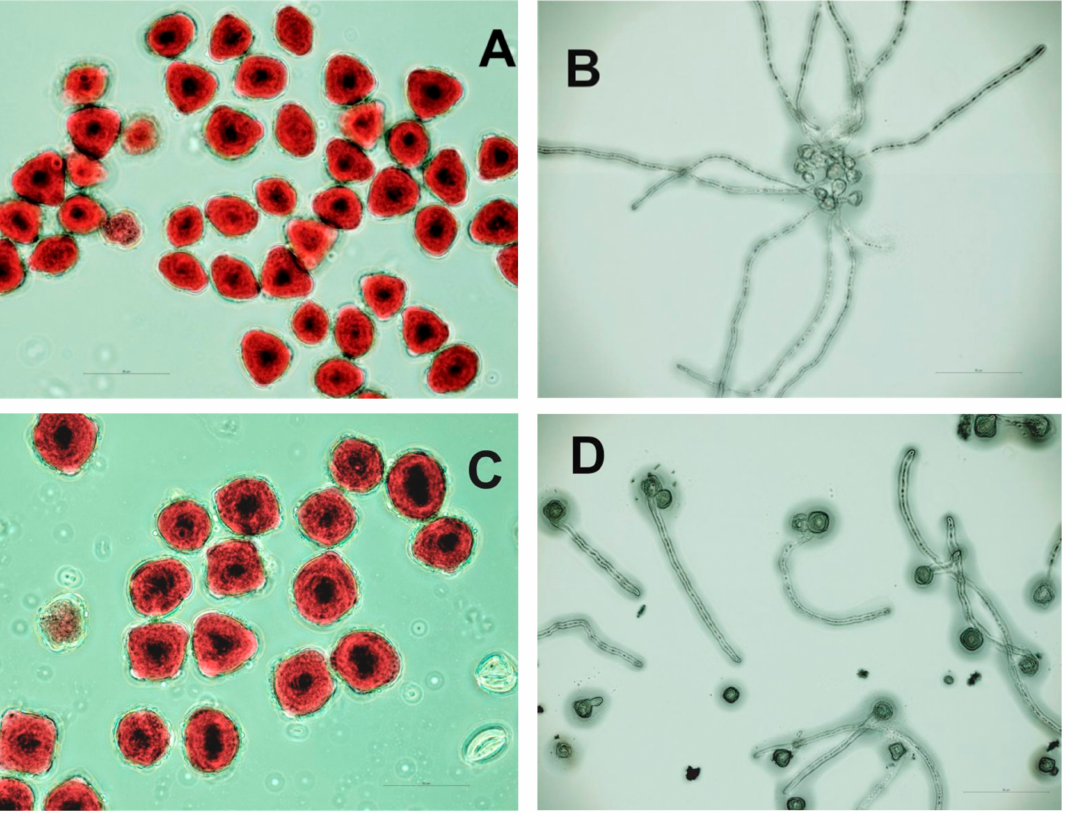
Figure 5. Differences between size and germination of pollen grains of diploid ( A , B ) and tetraploid ( C , D ) apple cv. ‘Redchief’; scale bars = 50 µ